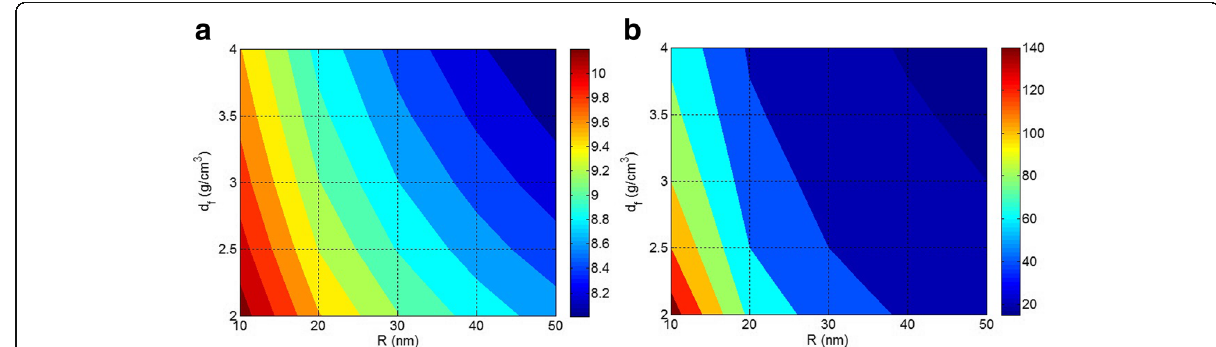
Fig. 3 The effects of R and d f on a ln (SE) with ln (m 2 GPa) unit and b A c (m 2 /g) at W f = 2 g and E f = 100